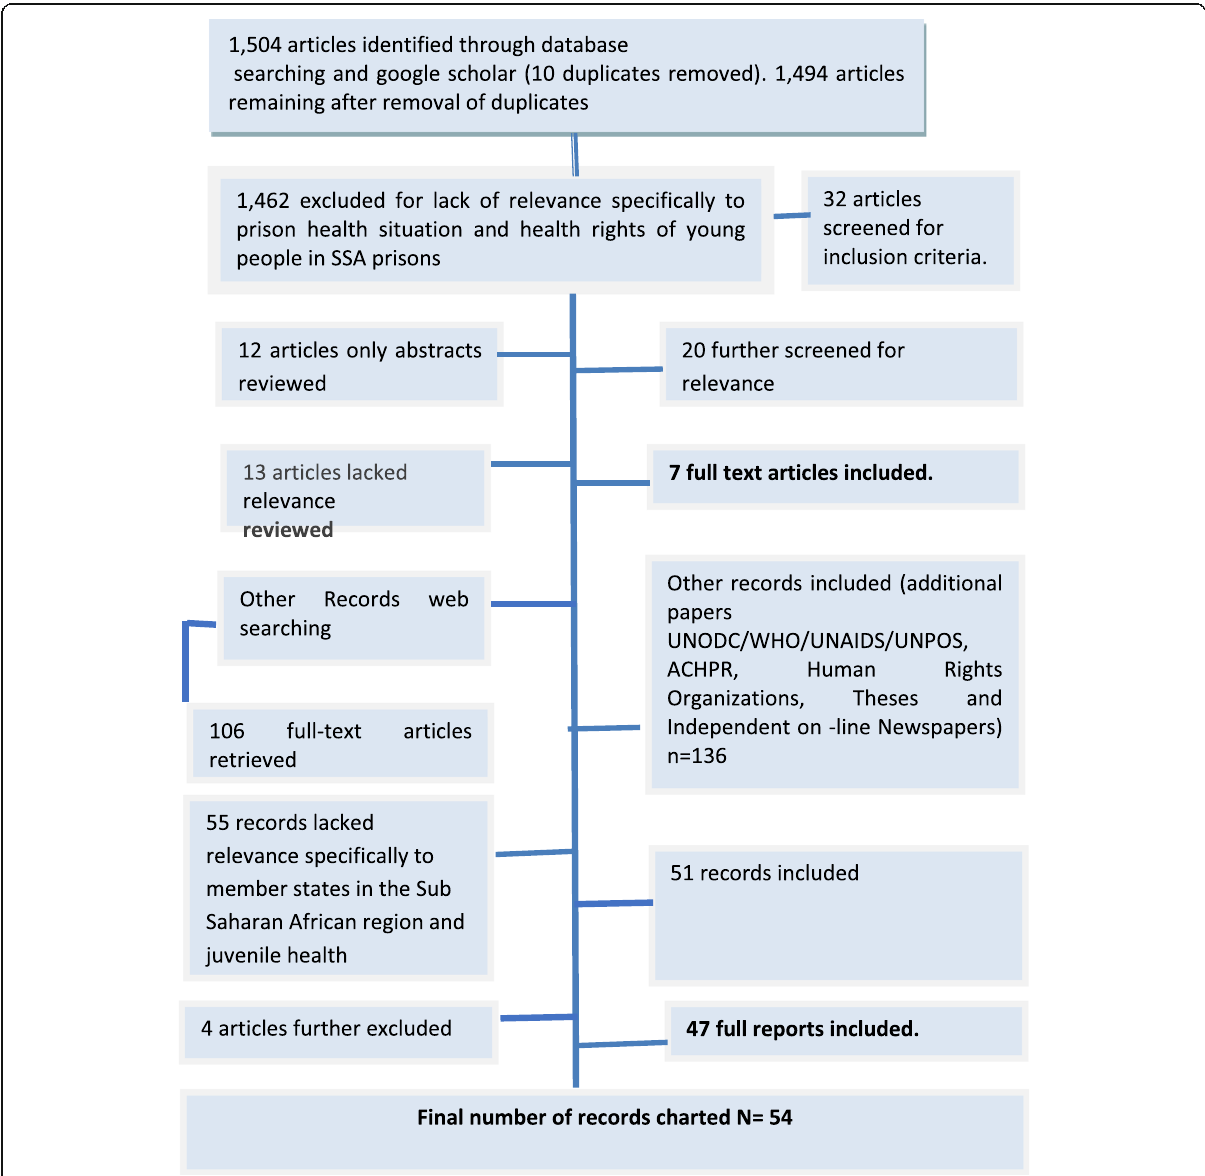
Fig. 1 Flowchart for inclusion and exclusion of